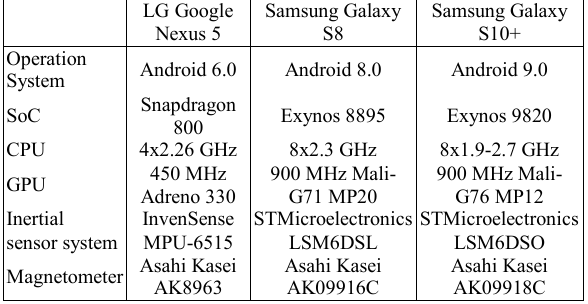
Table 1. Smartphone specifications. Abbreviations: